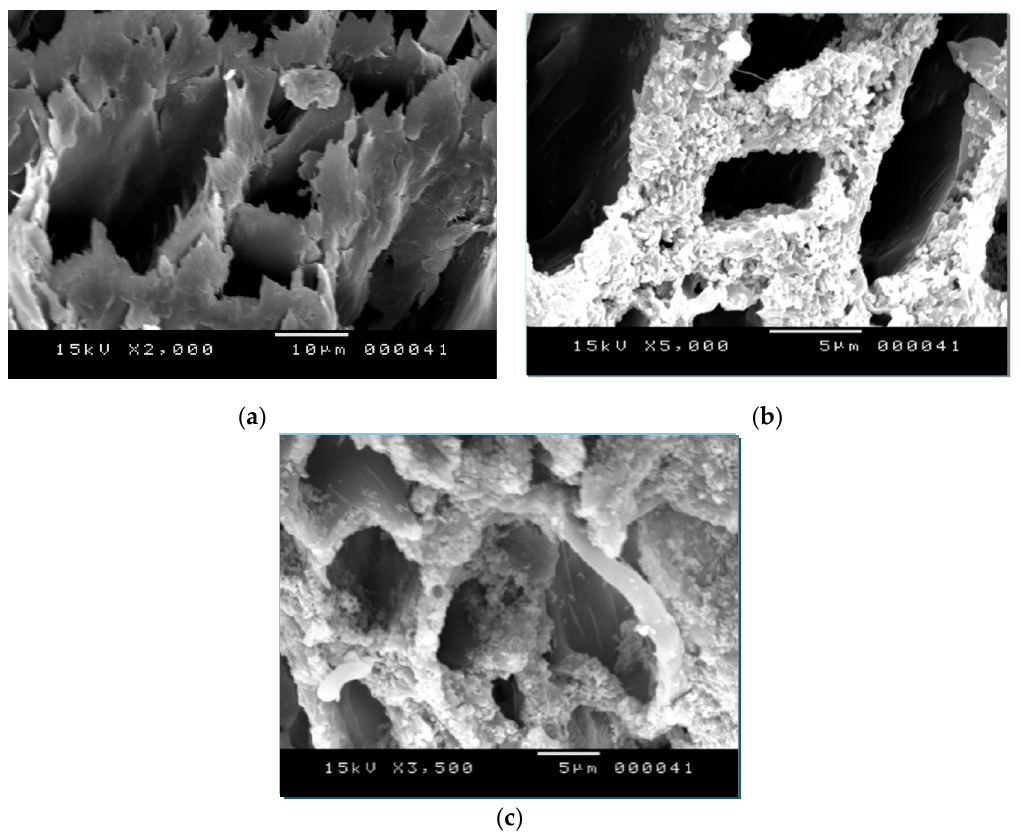
Figure 3. images of ( a ) pure L.C , ( b ) L.C + 4% Zn 2+ synthesized in absence of AC, ( c ) L.C + 4% Zn 2+ Figure 3. Images of ( a ) pure L.C , ( b ) L.C + 4% Zn 2 + synthesized in absence of AC, ( c ) L.C + 4% Zn 2 + synthesized in presence of AC. synthesized in presence of AC.